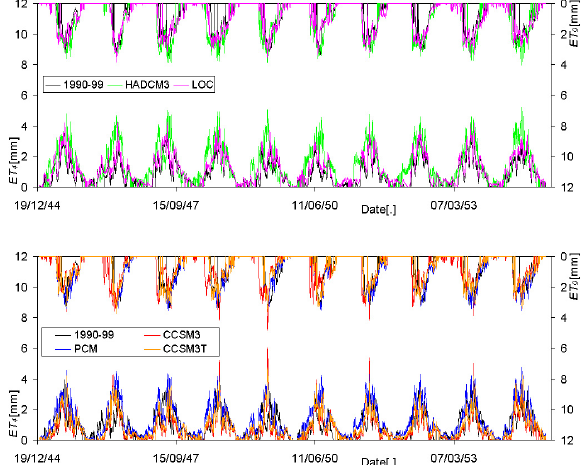
Fig. 7. Oglio at Sarnico. Scenario simulations, period 2045–2054. ET at belts 4 (1225m s.l.m.) and 9 (2975ms.l.m.). (a) LOC, HadCM3. (b) PCM, CCSM3,